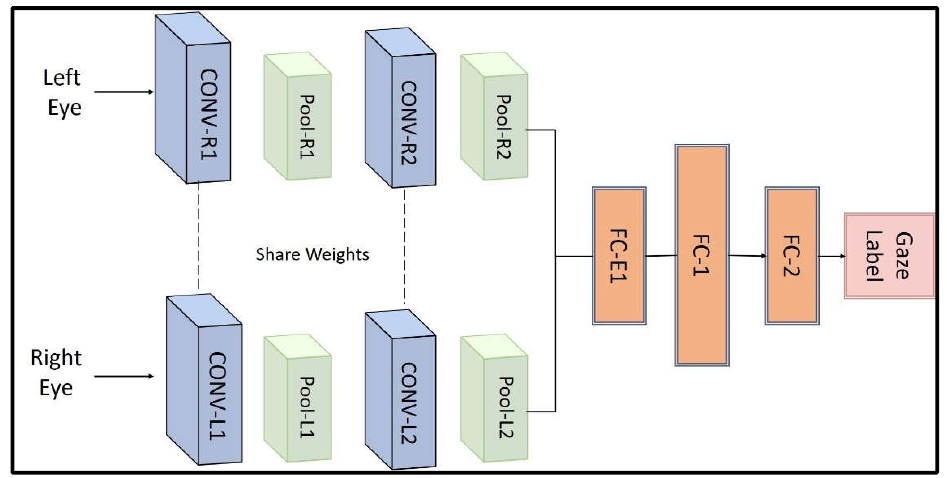
Figure 12. Architecture of CNN-based eye-gaze estimation algorithm. To train the network, a public dataset [24] of videos of 10 persons conducting head and eye motions similar to VORx1 exercises was used. Frames from the videos were extracted and labeled as “on-target” and “off-target” based on whether the gaze was directed towards the target regardless of head orientation (Figure 13). Left and right eye images were used as the network input and the output is the binary classification result.